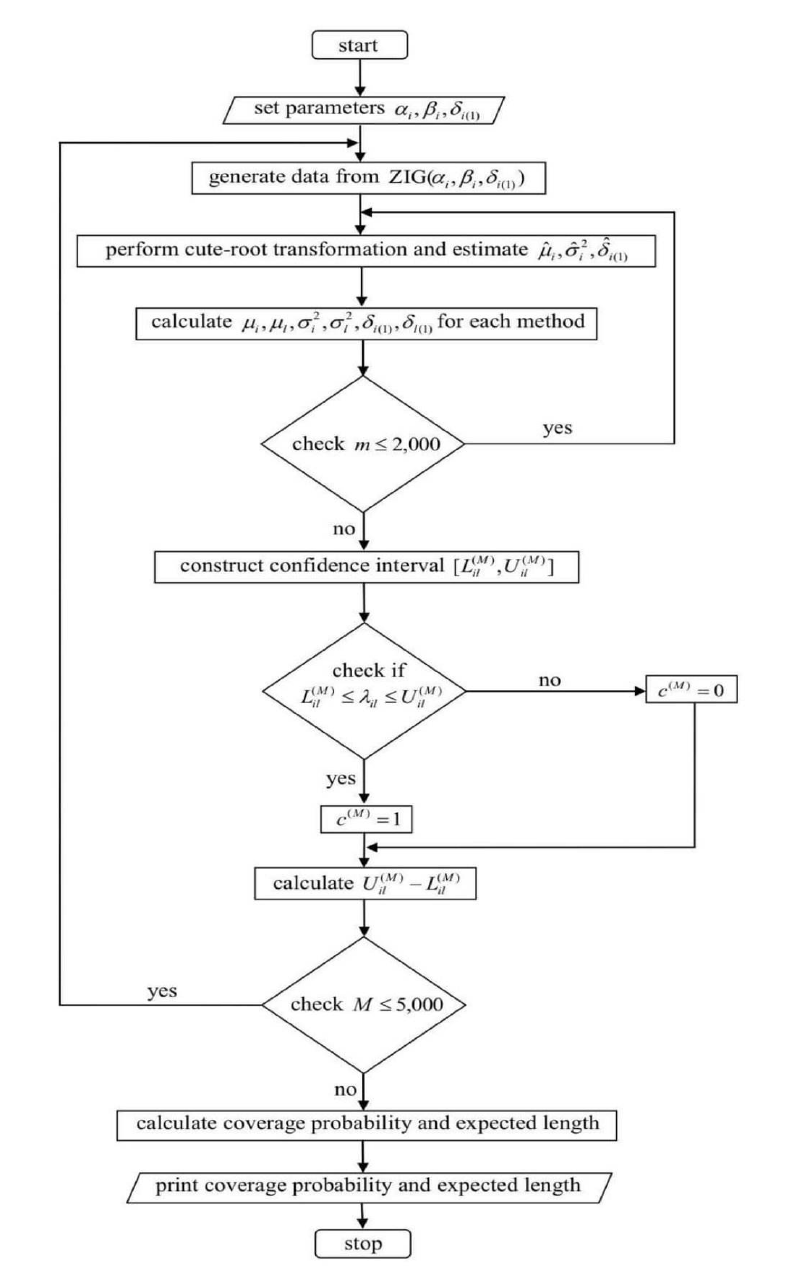
Figure 1. A flowchart of the simulation